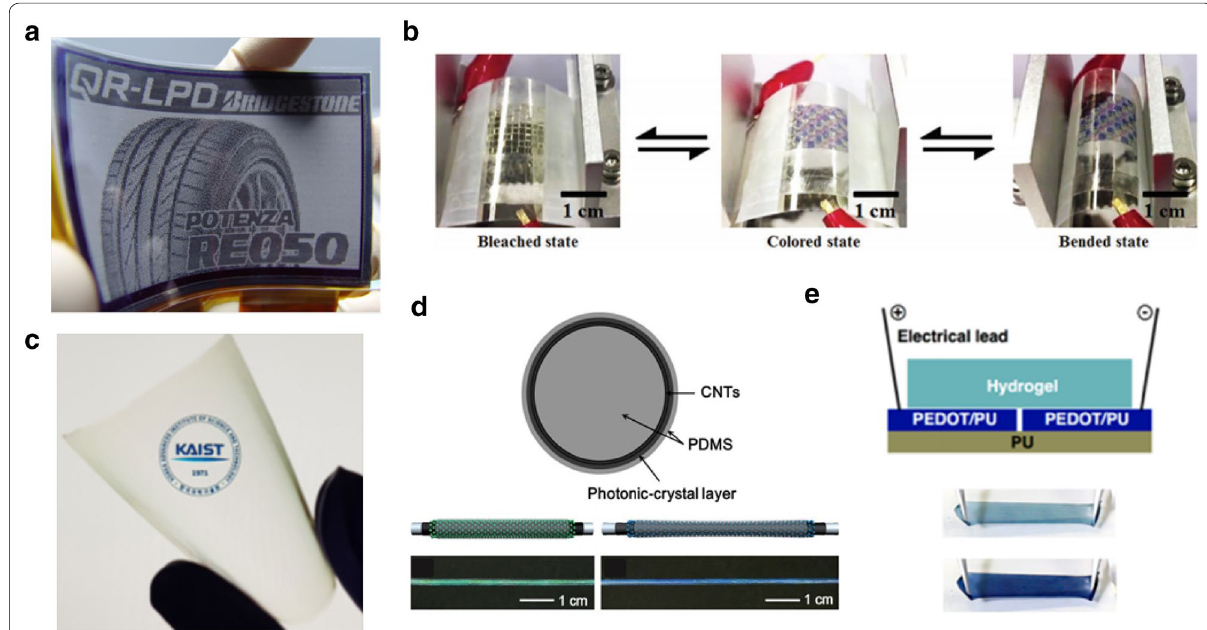
Fig. 12 Polymeric substrates for stretchable displays. a Flexible E‑paper display(QR‑LPD ® ) fabricated on PET substrate. b Flexible electrochromic display on ITO coated PET substrate during dynamic bending test. c Picture of a poly amide‑imide film with low CTE(~ 4 ppm/ °C) and high transparency. d Schematic structure of photonic crystal fiber and color change at given strain. Polystyrene particles are coated on PDMS core. e Stretchable electrochromic device fabricated on polyurethane(PU) substrate (Figure reproduced from a [18], Copyright 2006, Society for Information Display; b [35], Copyright 2019, WILEY‑VCH Verlag GmbH & Co. KGaA, Weinheim; c [85], Copyright 2018, The Author(s); d [90], Copyright